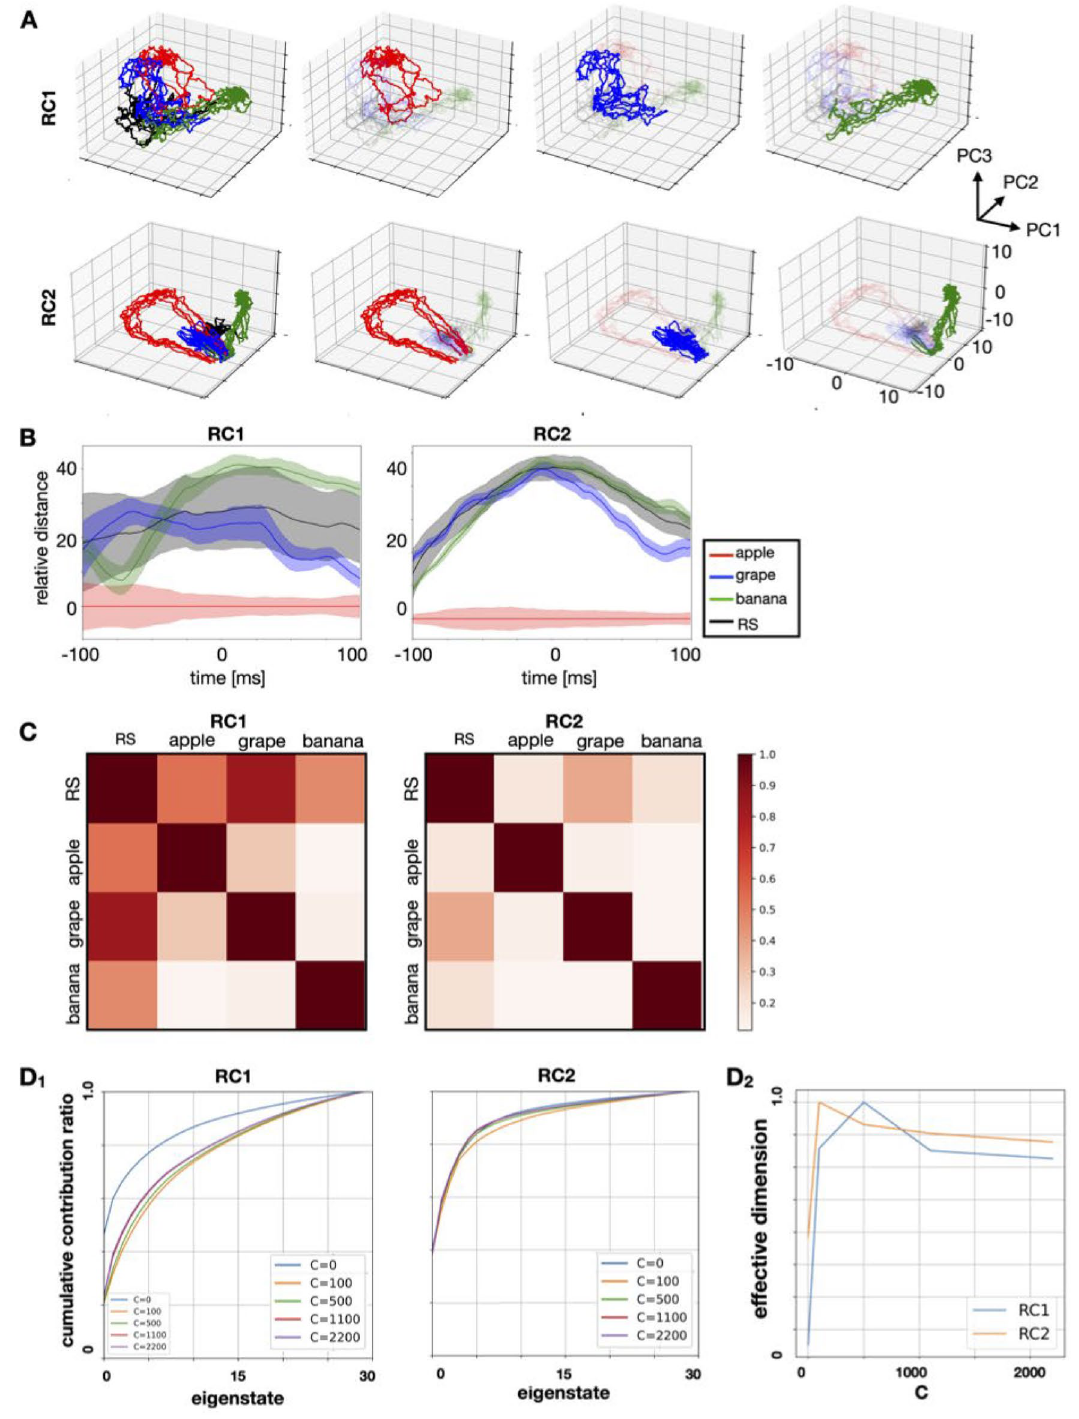
Figure 4. The characteristics of the trajectories of reservoir dynamics during stimulus presentation. ( A ) Results of projecting the activity inside the reservoir computing model for individual chunks (colored intervals) into the space from PC1 to PC3. Responses are self-organized for each chunk. The input contains a random sequence. Responses are color-coded according to their selectivity for chunks. Top: for the RC1 module. Bottom: for the RC2 module. ( B ) Distances between chunks of low-dimensional trajectories of d XY ( t ) reservoir dynamics. The distances were measured with respect to the “apple” trajectory (Y was set to “apple”). The shaded area X ( t ) indicates the deviation σ . Because presentation times vary between chunks, the midpoint of the presentation time was set to 0, r XY and the relative time from that point was used to display the data. ( C ) The degree of separation between trajectories. The left and right sides indicate RC1 and RC2, respectively. The degree was defined in the Methods sections. The smaller the value is, the longer the distance between trajectories. ( D 1 ) Change in the cumulative contribution ratio before and during learning. The ratios for RC1 and RC2 are displayed on the left and right sides, respectively. ( D 2 ) Changes in the effective dimension trajectories for RC1 and RC2 after an increasing number of learning iterations. See the “Methods” section for the calculation of the effective dimension. PC principal